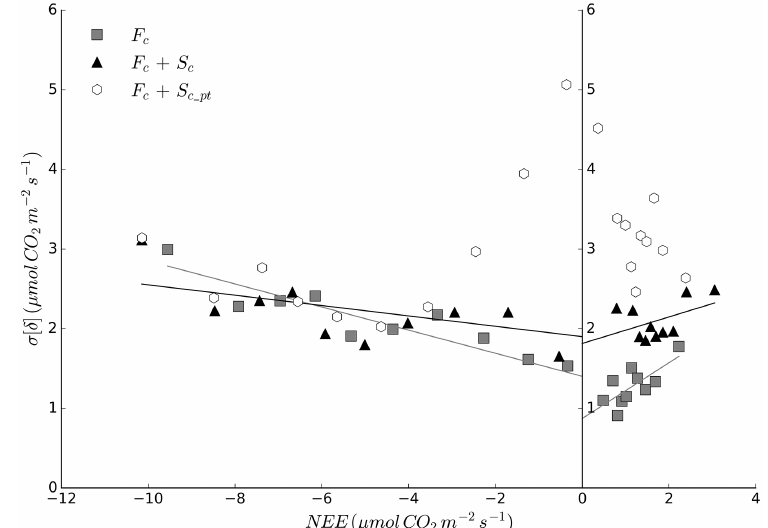
Figure 13. Standard deviation of estimated random error ( σ [ δ ] ) as a function of flux magnitude for turbulent flux ( F c ) , turbulent flux plus profile-based storage estimate ( F c + S c ) and turbulent flux plus point-based storage estimate ( F c + S c _pt )